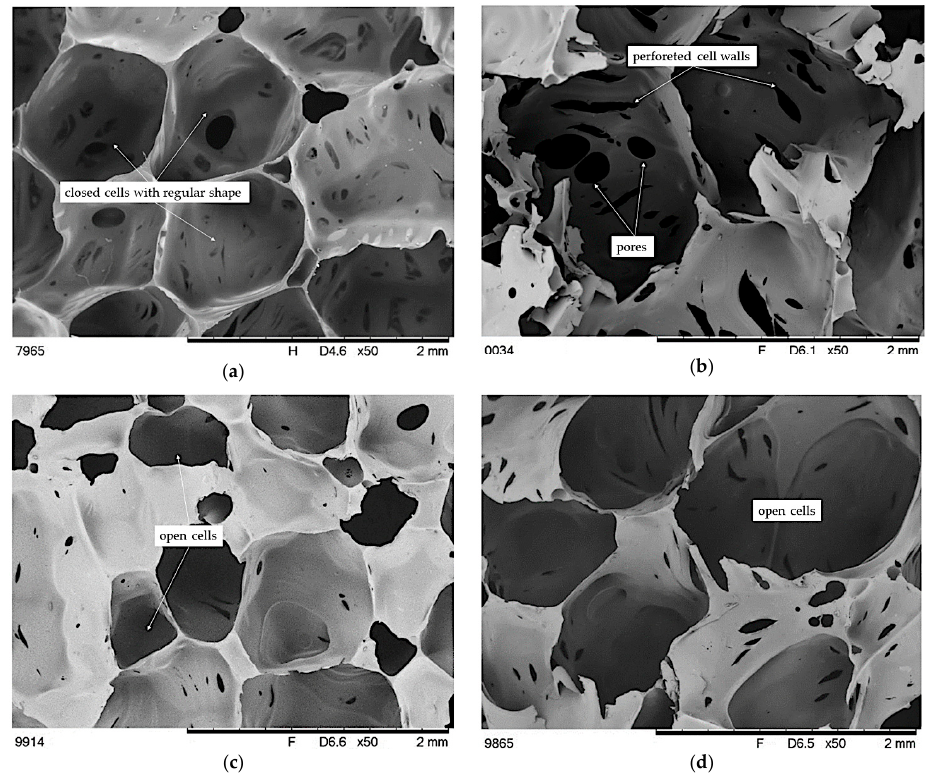
Figure 8. SEM microphotographs of brittle fracture of foams: ( a ) VEF, ( b ) VEFS5, ( c ) VEFL15, and ( d ) VEFX15.